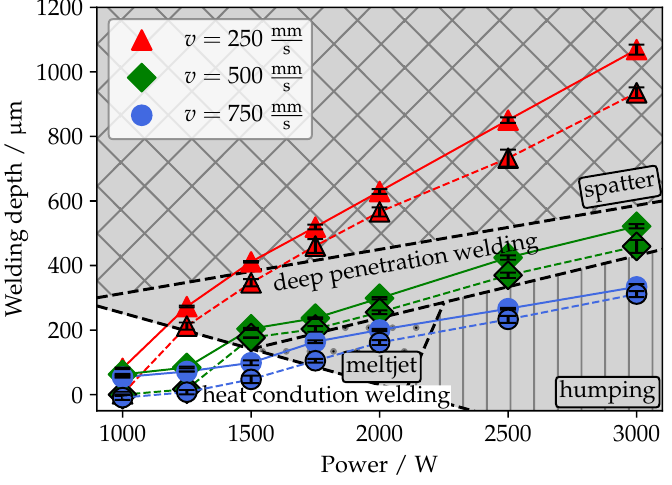
Figure 7. Mean welding and capillary depth ( n = 6); no outline: weld seam depth; with outline: capillary depth measurement, white: heat conduction welding, grey: deep penetration welding, cross pattern: increased spatter formation with spatter sizes > 100 µ m, dotted area: jet effect of the molten material, vertical lines: